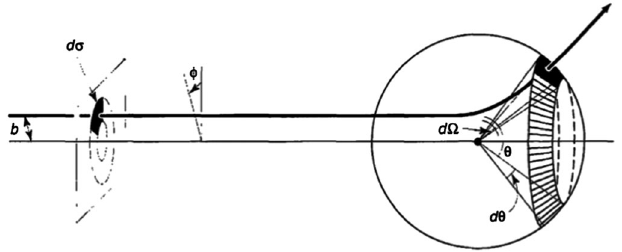
FIG. 2. A central problem in scattering theory is to characterize the probability of scattering in a given direction, essentially the scattering amplitude [ f ð k; θ Þ ], which depends on the incident cross section ( d σ ) as compared to the solid angle ( d Ω ) it scatters into. Figure reproduced from D. J. Griffiths Introduction to Quantum Mechanics